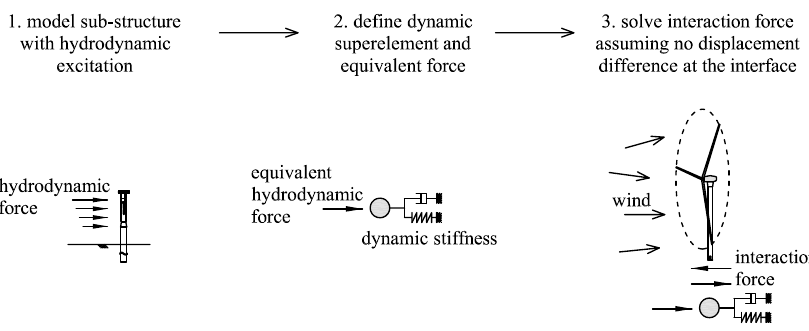
Figure 17. Schematization of the dynamic sub-structuring technique for offshore wind turbines